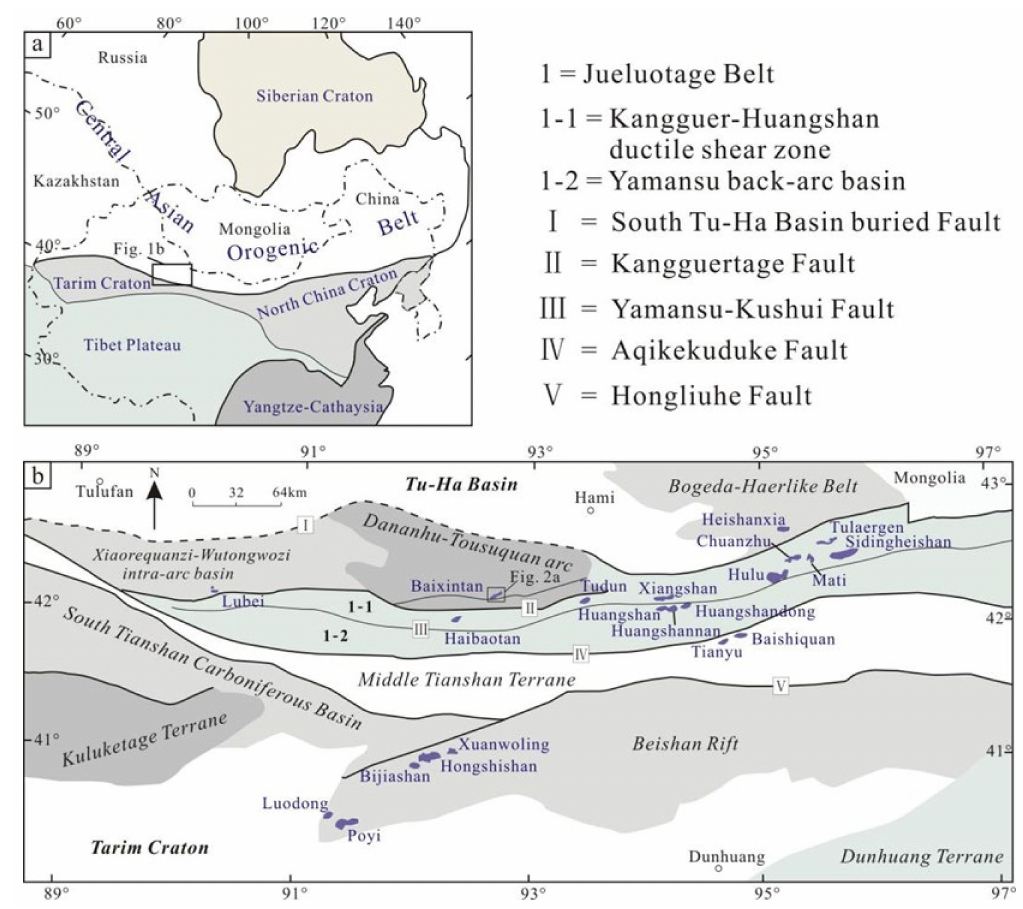
Figure 1. ( a ) Simplified geological map showing the location of the study area in the Central Asian Orogenic Belt (CAOB) (modified by [60]); ( b ) distribution of Ni-Cu ore-bearing mafic-ultramafic intrusions in the Eastern Tianshan orogenic belt and Beishan Rift (modified from